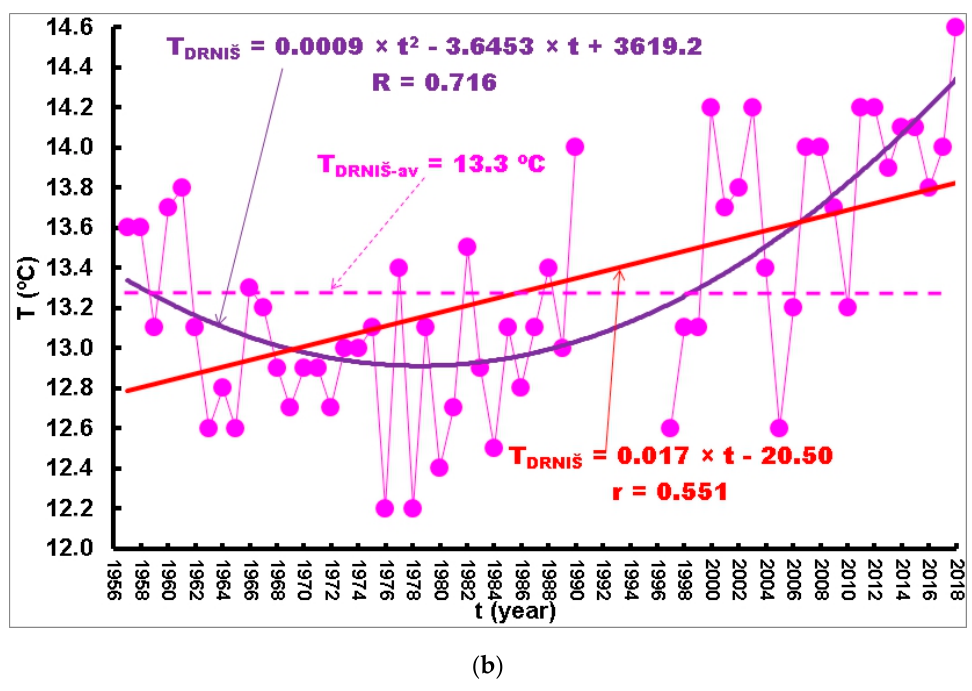
Figure 5. Time series of annual precipitation ( a ) and mean annual air temperature ( b ) measured at the meteorological station Drniš over the period 1957–2018 (1991–1997 missing data due to war activity).